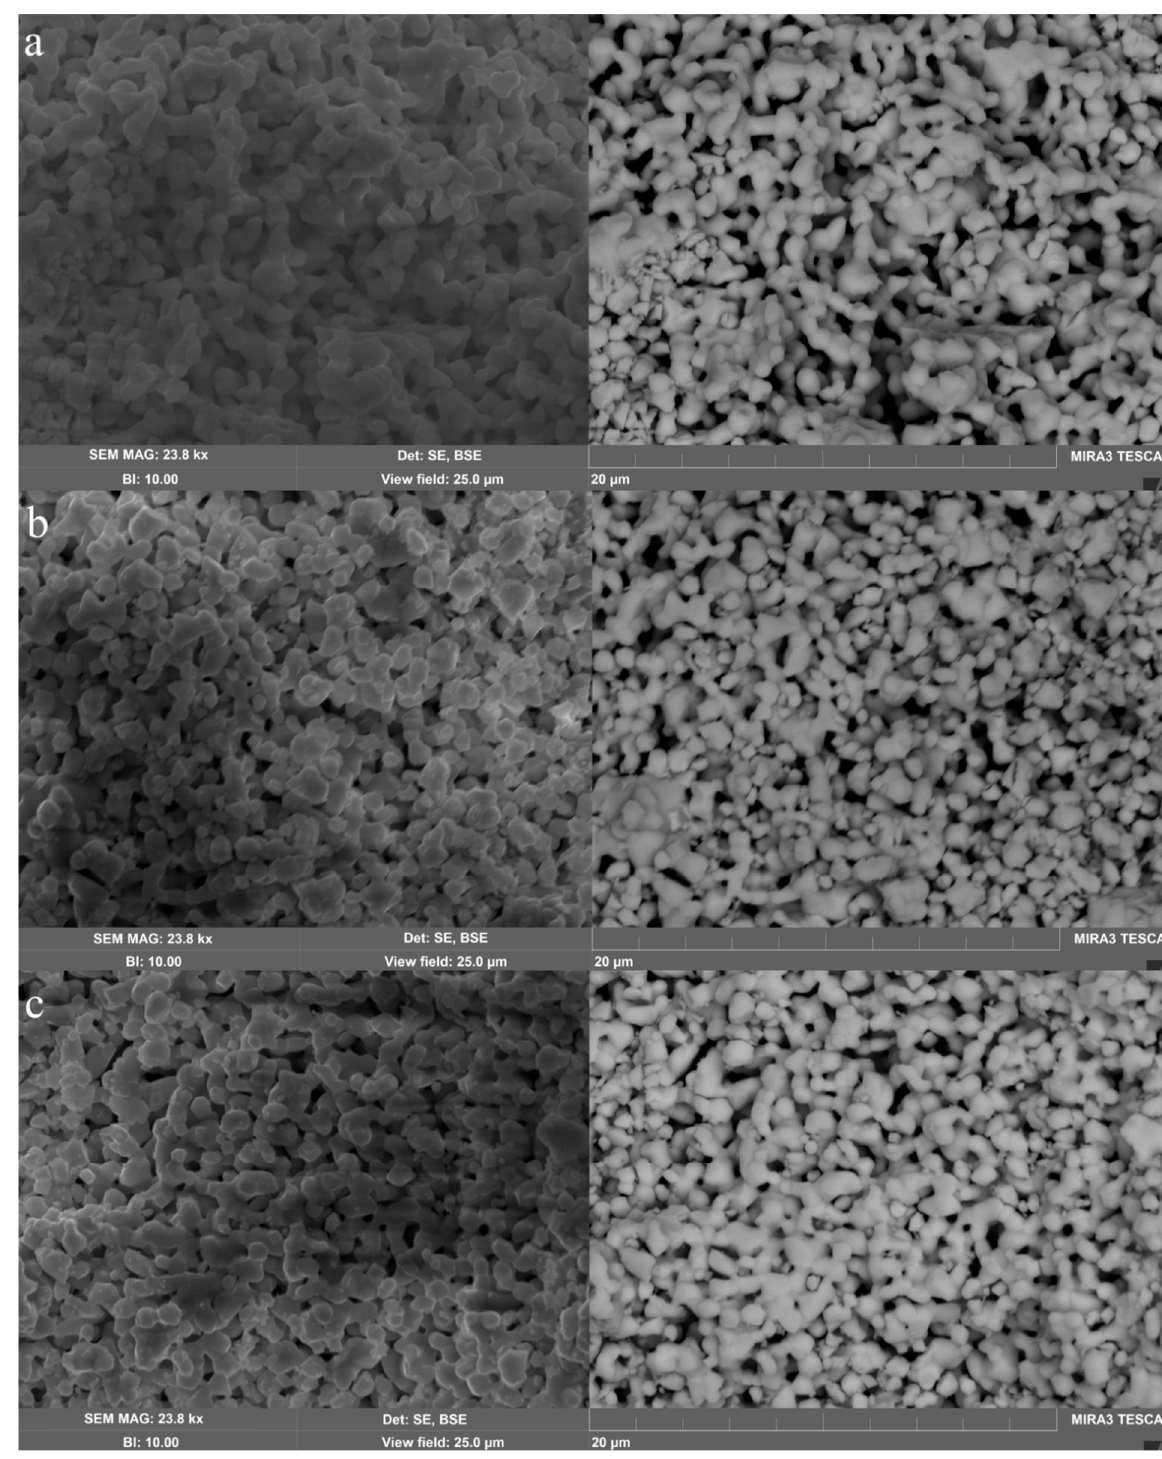
Figure 4. SEM micrographs of the Bi 2 Mg x Fe 1-x Ta 2 O 9.5- Δ ceramics at x = 0.7 ( a ), 0.5( b ), 0.3( c ).